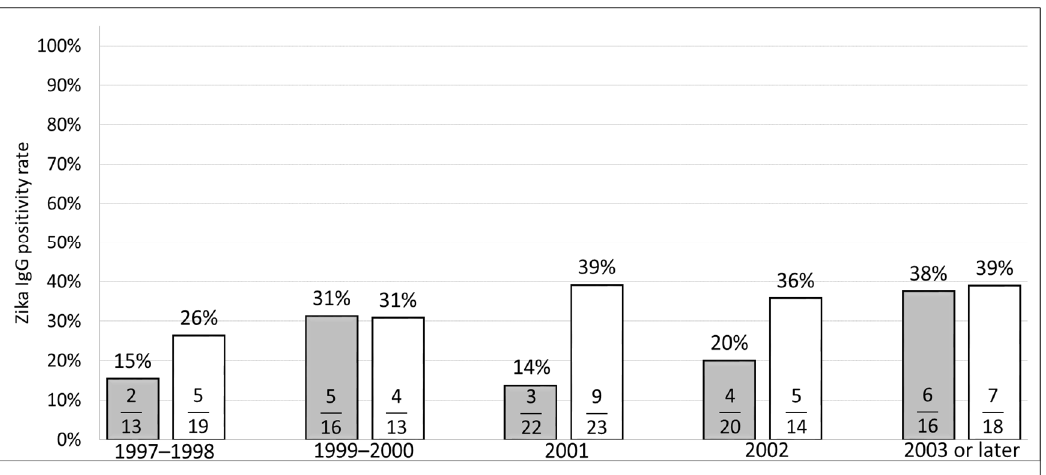
Figure 1. Zika virus IgG serology between 1997 and 2015. In the univariable and multivariable logistic regression analysis, there were no signifi- cant associations between the occurrence of individual adverse outcomes and ZIKV IgG positivity after adjusting for potential confounders. There was no association between the level of the CD4 cell count and ZIKV IgG positivity; the median (IQR) CD4 cell count was 366 (270 to 526) cells/mm 3 in ZIKV IgG positive women versus 340 (237 to 534) cells/mm 3 in ZIKV IgG negative women ( p =